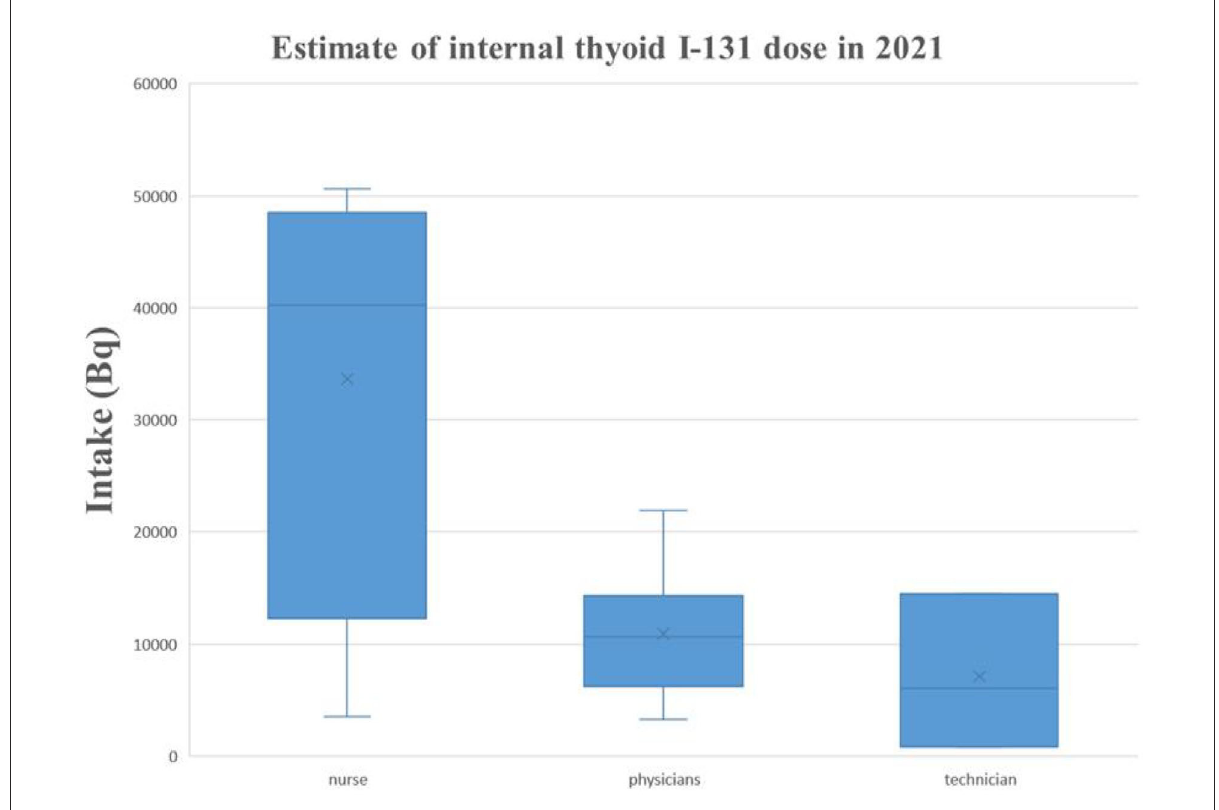
FIGURE2 Estimate of internal thyroid 131 I intake (Bq) in